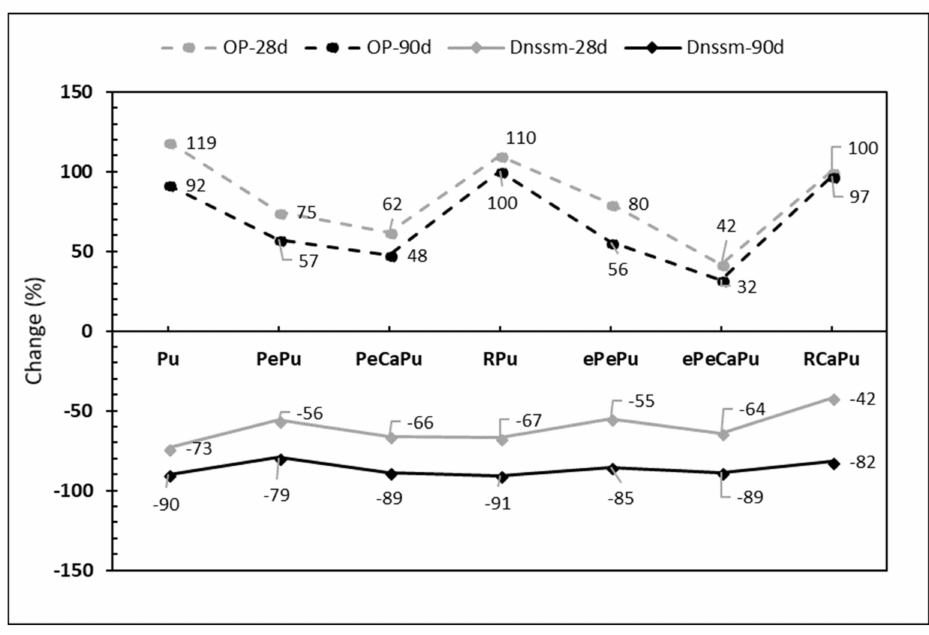
Figure 4. Changes (%) over curing time (28–90 days) of open porosity (OP) and chloride migration coefficient (D nssm ) of LWC, with respect to the REF mixture.